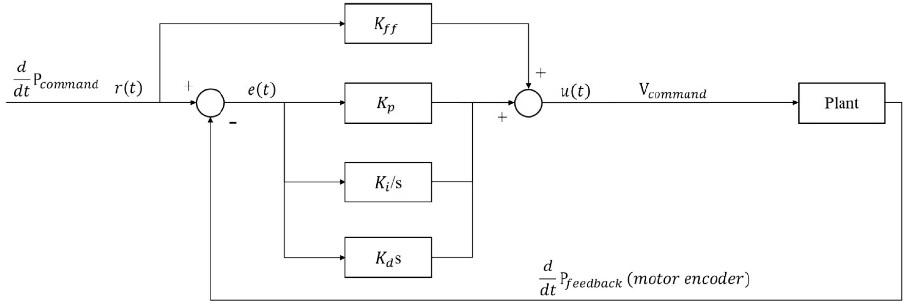
Figure 7. Architecture of PCI ‐ 8143 motion card controller [14].